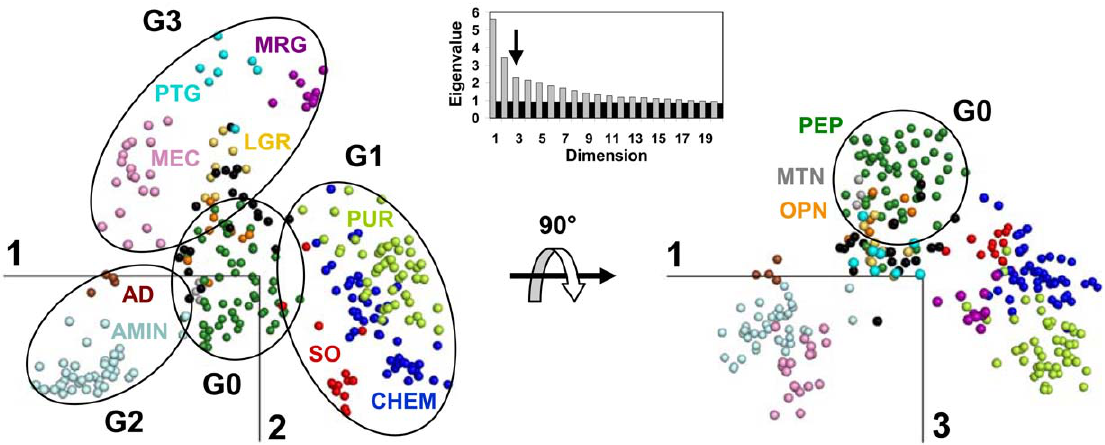
Figure 2. MDS representation of human non-olfactory class A GPCRs. Data are projected onto the planes defined by the first and the second components (left) and by the first and the third components (right). The insert displays the scree plot of the first twenty eigenvalues obtained from the MDS analysis of human GPCRs (grey bars) and, for comparison, the eigenvalues obtained from a random MSA with the same characteristics as human GPCRs (black bars). The color code refers to the GPCR sub-families (AD: brown; AMIN: light blue; CHEM: dark blue; LGR: yellow; MEC: pink; MTN: grey; MRG: violet; OPN: orange; PEP: dark green; PTG: cyan; PUR: light green; SO: red; UC: black). doi:10.1371/journal.pone.0019094.g002 PLoS ONE |